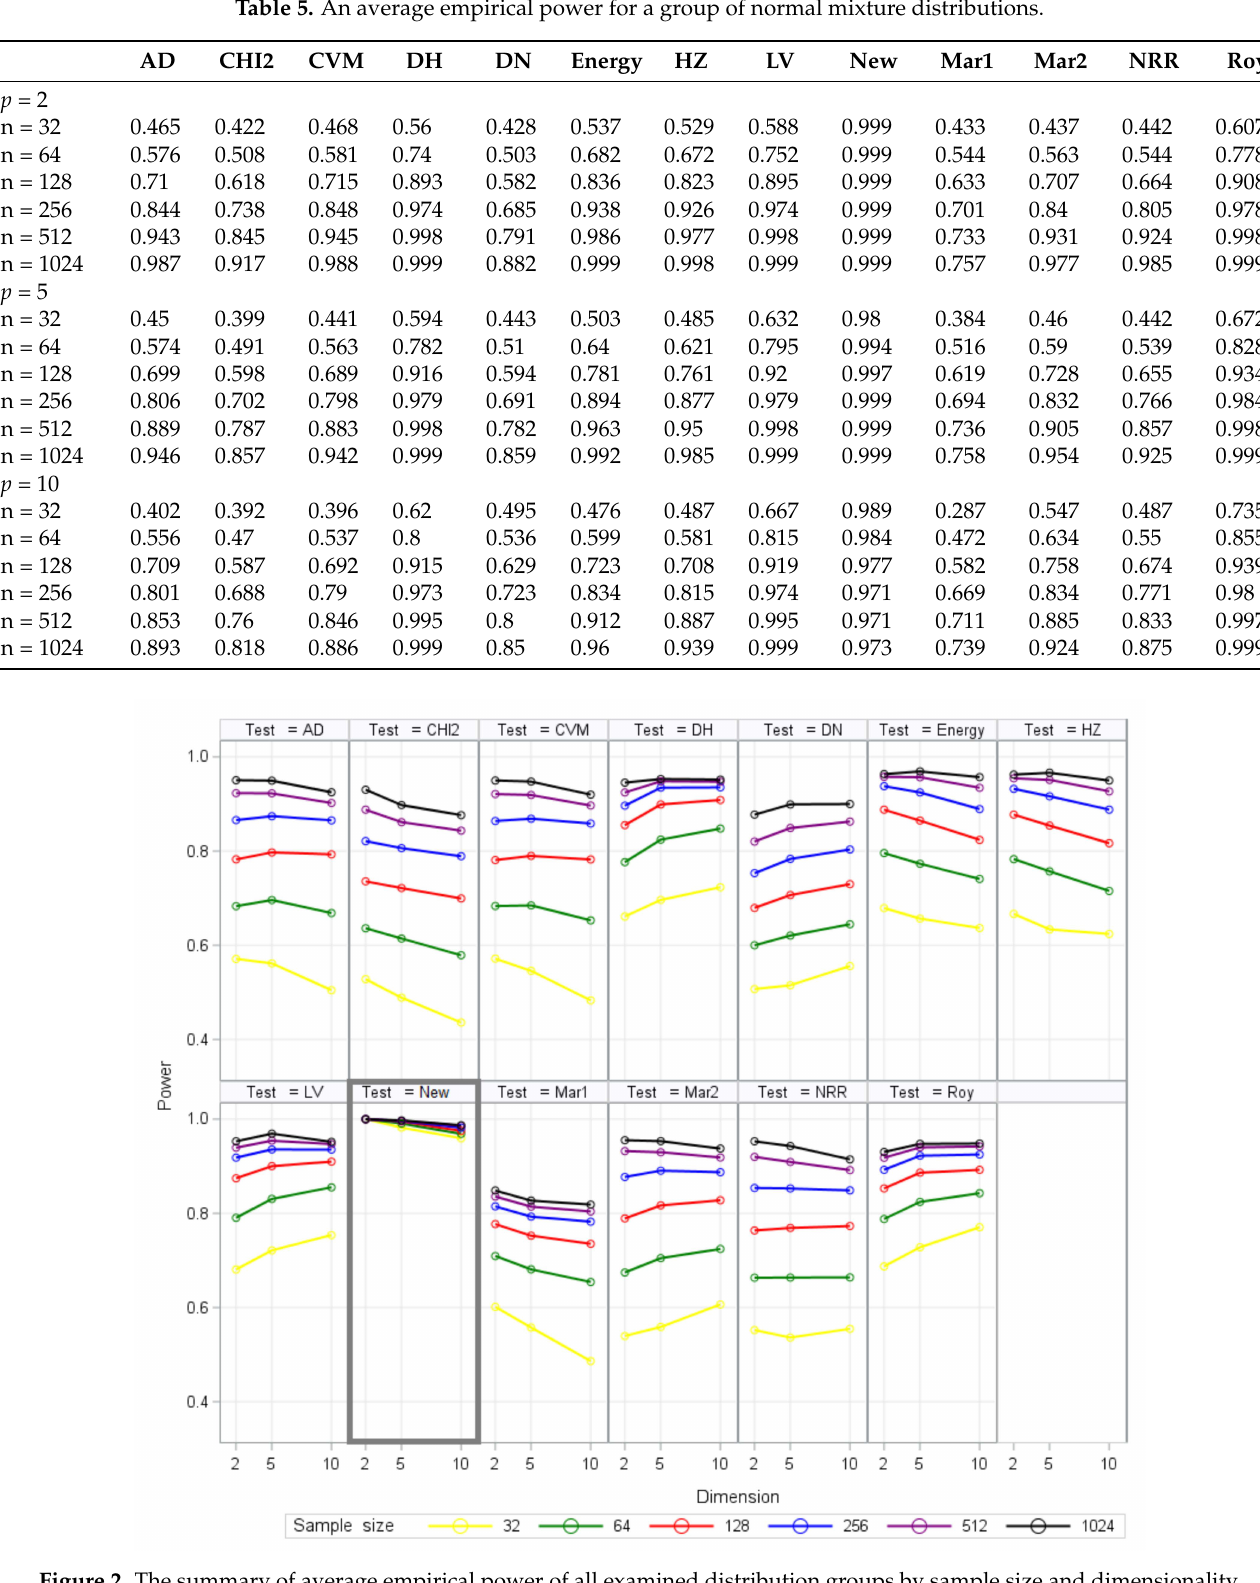
Figure 2. The summary of average empirical power of all examined distribution groups by sample size and